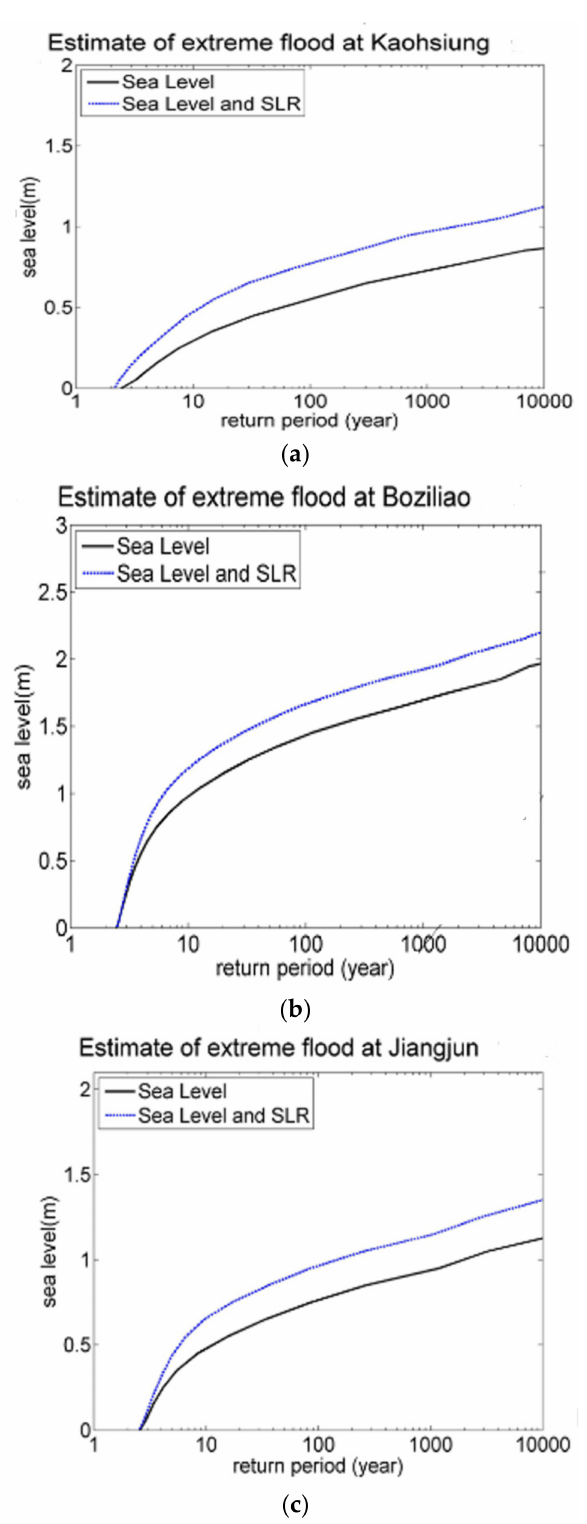
Figure 9. The spatial distribution of tide-gauge stations around Tainan and their extreme flood estimation ( a ) Kaohsiung station, ( b ) Boziliao station and ( c ) Jiangjun